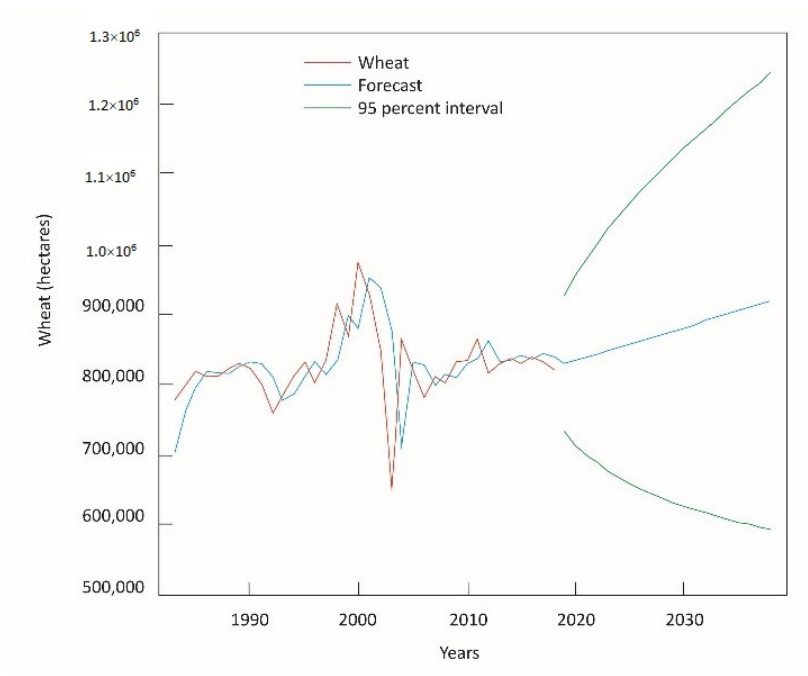
Figure 2. Prediction of the development of wheat-sowing areas in the Czech Republic.